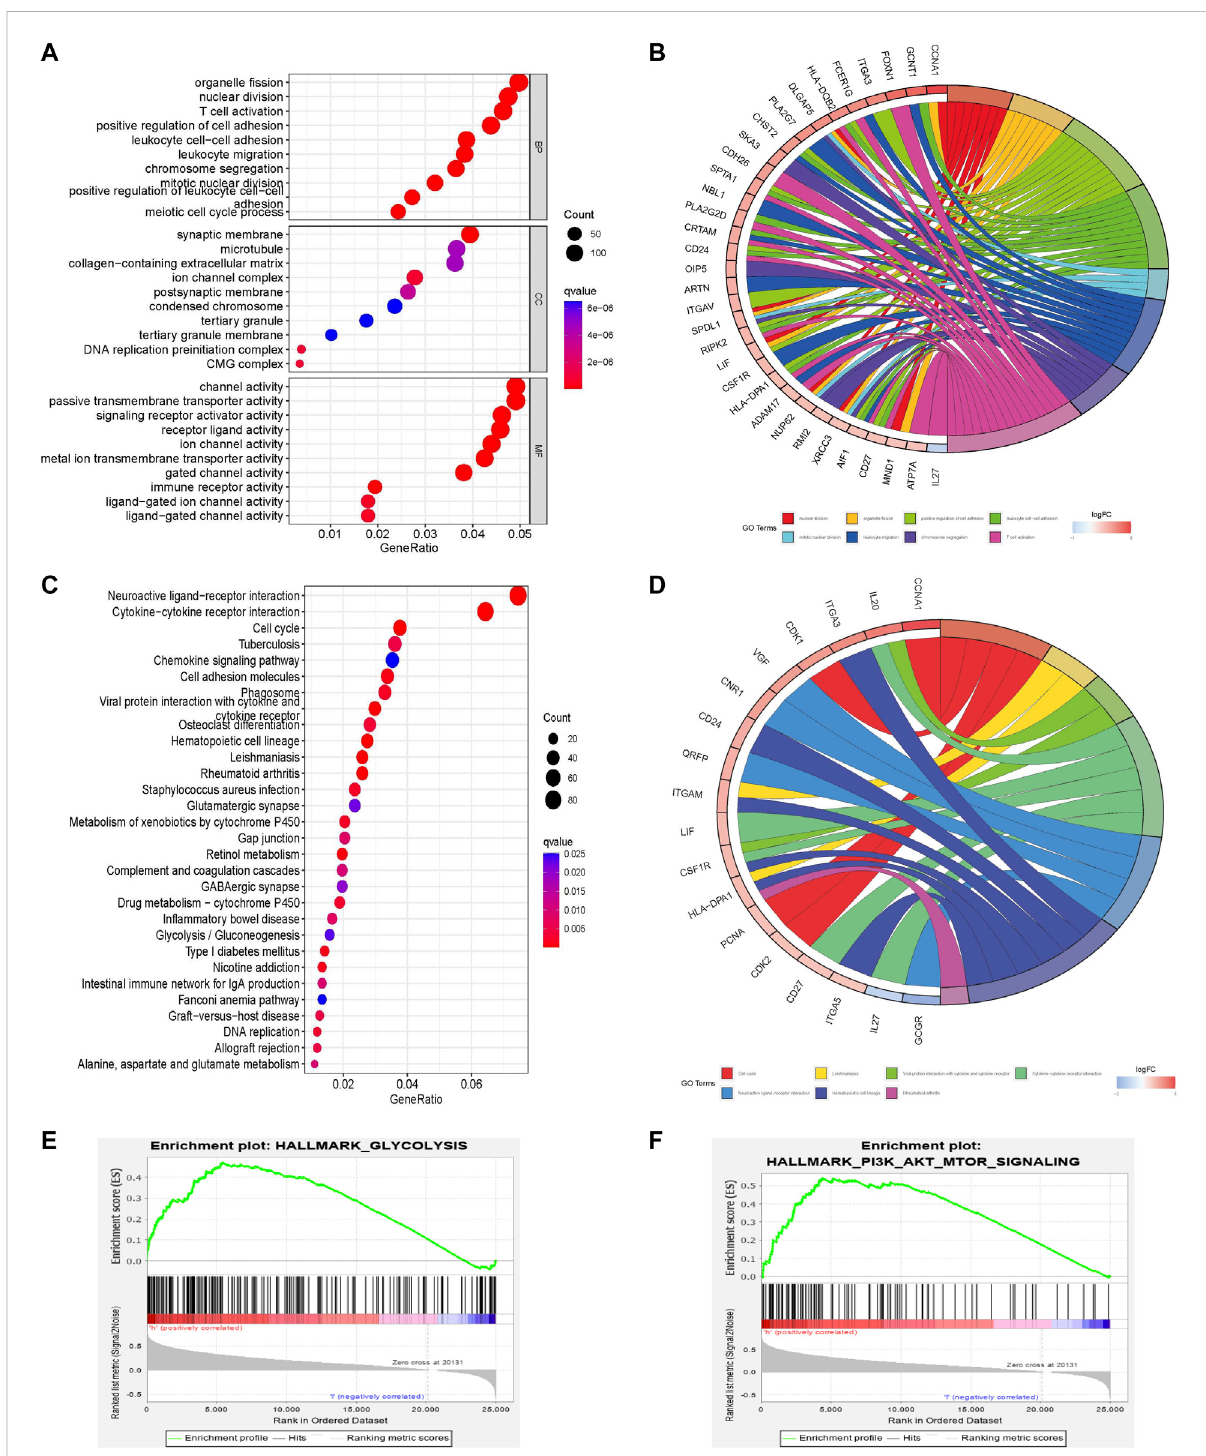
FIGURE 4 Pathwayenrichmentanalysiscomparingdifferentriskscoresassociatedwithglycometabolism. (A – D) GOandKEGGenrichmentanalysisofthe top 30 pathways and genes of different glycometabolism-related risk scores. (E,F) Comparison of the enrichment of the “ hallmark all. v7.5. symbols ” pathway in GSEA of different glycometabolism-related risk